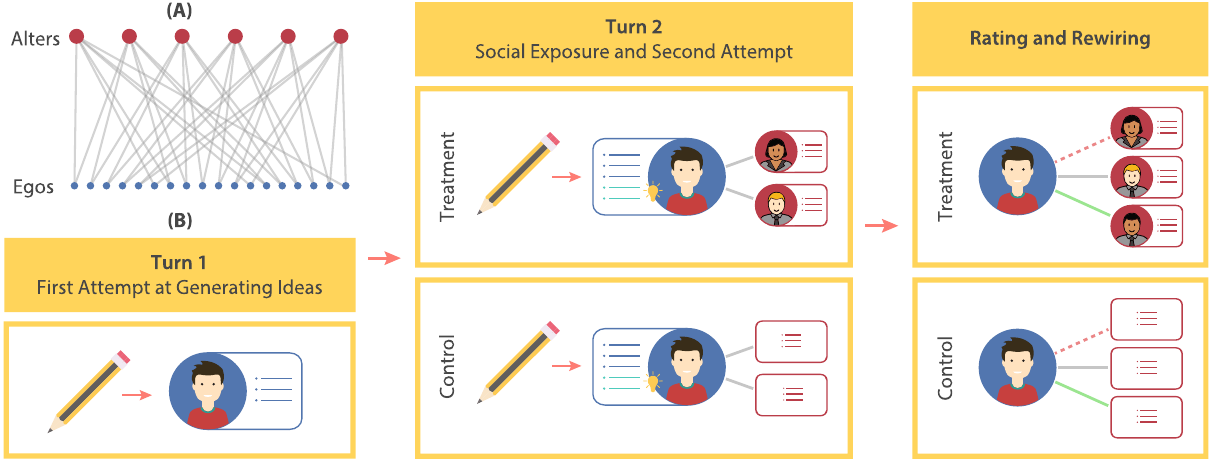
Figure 1. Experimental setup. ( A ) The bipartite network used as the initial configuration. Pre-recorded ideas of the alters were shown to the egos of both study conditions. Each ego was connected to 2 alters. ( B ) The study protocol for each of the 5 rounds. In turn-1, the egos generated ideas independently. Turn-2 involved an additional idea-generation task on the same object. In this turn, the control egos were shown only the ideas of their alters for inspiration, while both the ideas and the demographic information of the alters were shown to the treatment egos. The egos could add inspired ideas to their lists. Finally, the egos rated the ideas of all the alters in the trial, and optionally updated the 2 followee-alters at the end of each round. In the illustration, the ego dissolved the red dashed link to form the green link, while the grey link